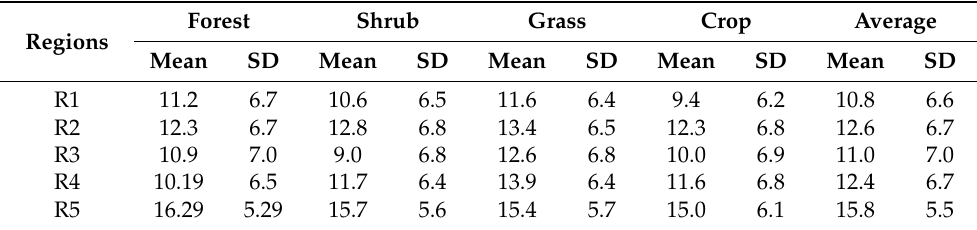
Table 3. Effects of ozone pollution ( I ozone ) on vegetation growth in China. The unit is %.